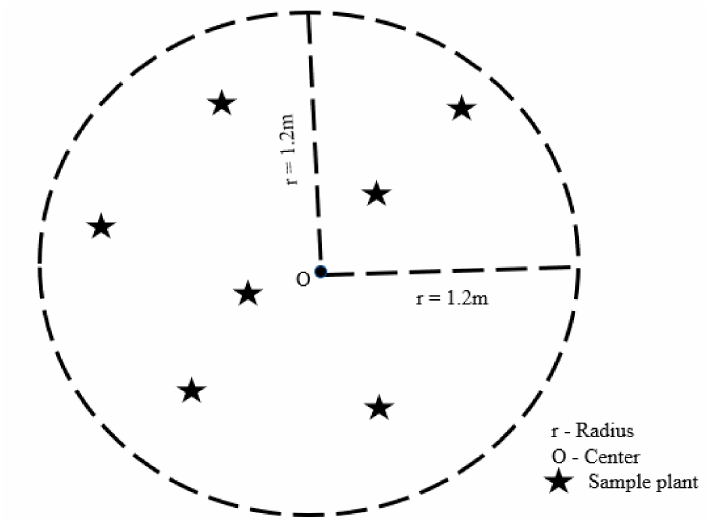
Figure 2. A schematic diagram showing an observation point for the measurement of vegetation height in different zones in woodlands, June–August